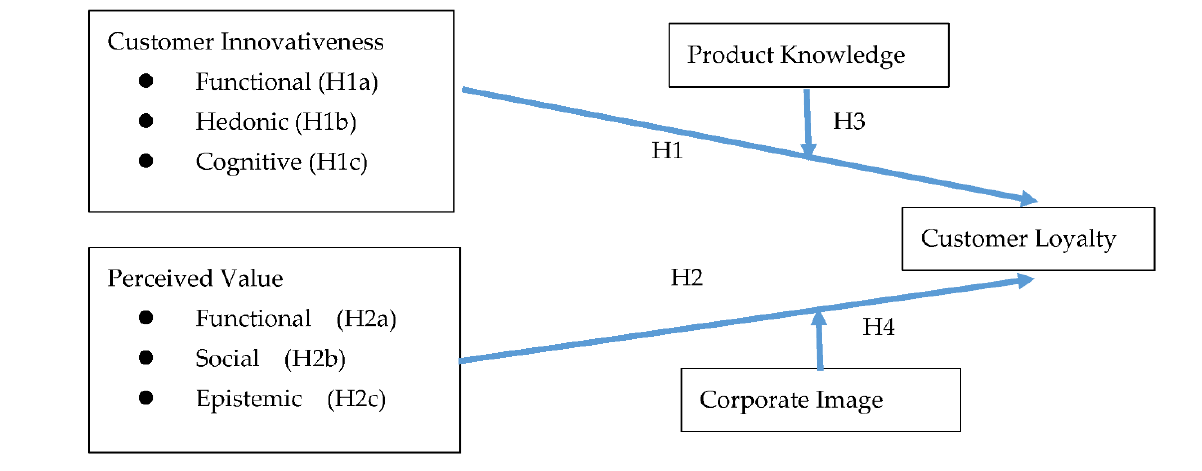
Figure 1. Research framework.